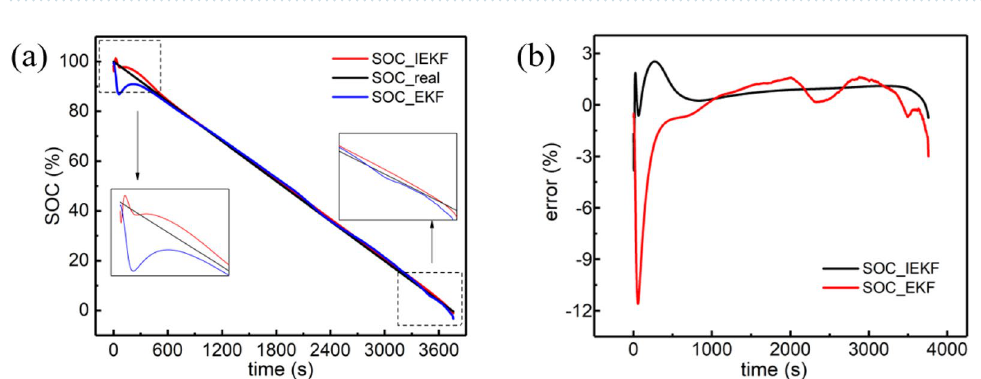
Figure 7. Results of IEKF used on 1C constant discharging condition: (a) result compared with EKF; (b) error